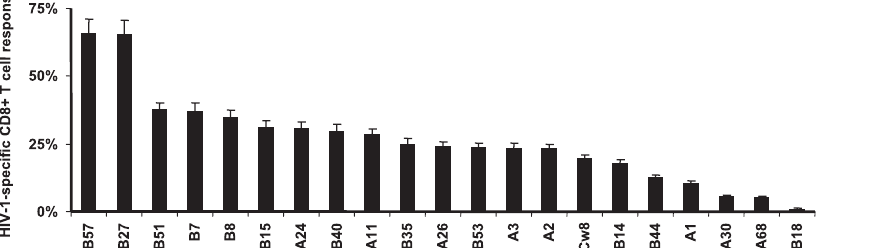
Figure 3. Different HLA Class I Alleles Differ in Their Contribution to the Total HIV-1-Specific CD8 þ T Cell Response The percentage contribution of HIV-1-specific CD8 þ T cell responses restricted by each individual HLA class I allele to the total HIV-1-specific CD8 þ T cell response in individuals expressing the respective allele is shown. HLA class I alleles are listed according to their contribution from left to right. HLA-B57 and HLA-B27 contributed 66% and 65.4%, respectively, to the total HIV-1-specific CD8 þ T cell response in individuals expressing these alleles. DOI: 10.1371/journal.pmed.0030403.g003